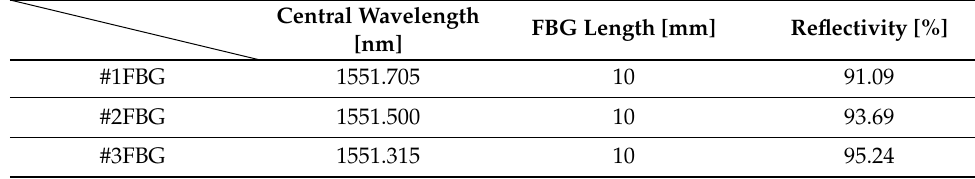
Table 3. Detailed parameters of FBG.